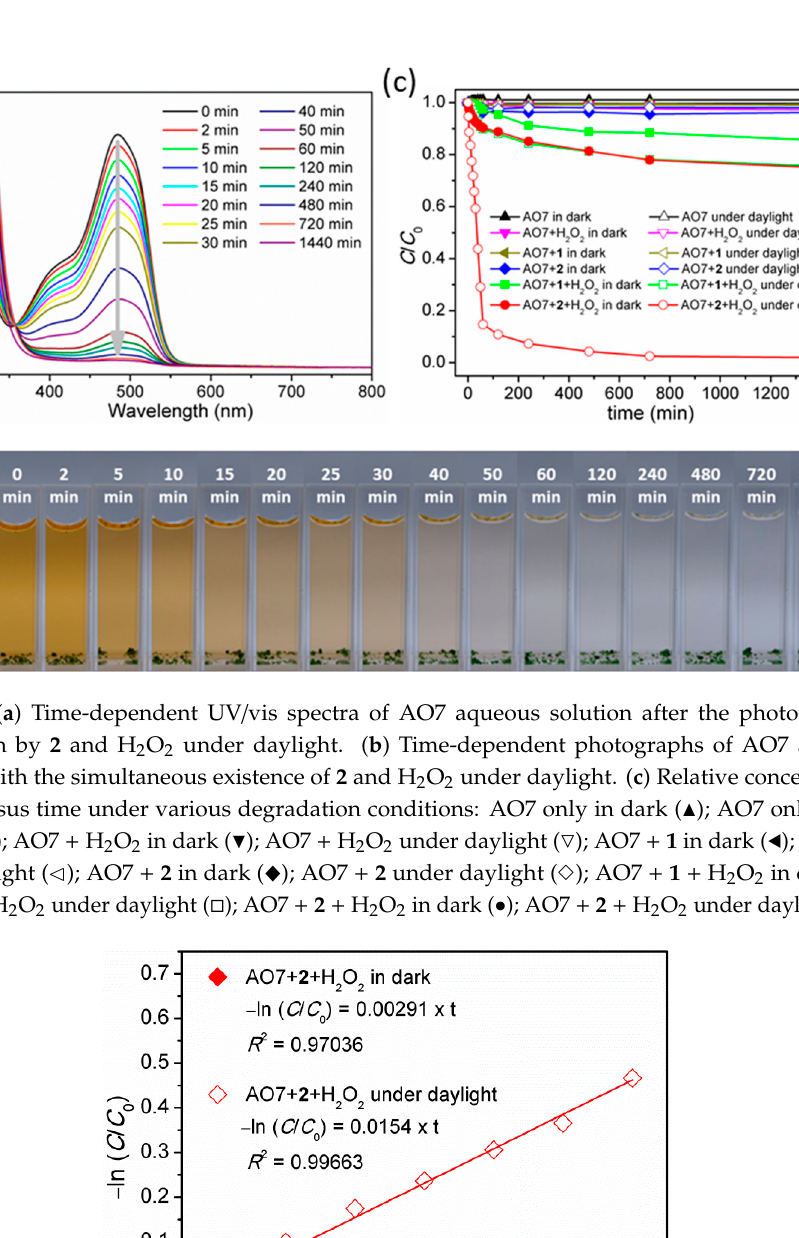
Figure 7. Relative concentration of AO7 versus time after the photocatalytic degradation by 2 and H 2 O 2 in different concentrations of 2 under daylight. Conditions: initial concentration of AO7 = 20 mg L − 1 , H 2 O 2 = 1 mL (30%). The possible reaction mechanisms are proposed. The preliminary experiments carried out in different conditions have clearly indicated that the degradation of AO7 only taken place when Cu(II) complex ( 1 or 2 ) and H 2 O 2 were collaborated. In addition , the degradation performance of AO7 by 1/ H 2 O 2 and 2/ H 2 O 2 would be significantly improved (acceleration and enhancement) under daylight in compared to that in dark conditions. These observations imply that advanced oxidative processes (AOPs) [22], which is worked by the in situ generated active hydroxyl radical ( • OH) as oxidizing agent to oxidatively degrade dyes, have been applied to the degradation of AO7 dye and there might be multiple pathways to dominate the AOPs. In general, the water-insoluble Cu(II) complexes can react with H 2 O 2 to produce • OH radicals via homolytic cleavage or • OH and HO 2• radicals via Cu redox cycles for degrading AO7 dye both in dark and under daylight [66–68]. However, daylight irradiation might result in Cu-based Fenton processes that would cause the generation of